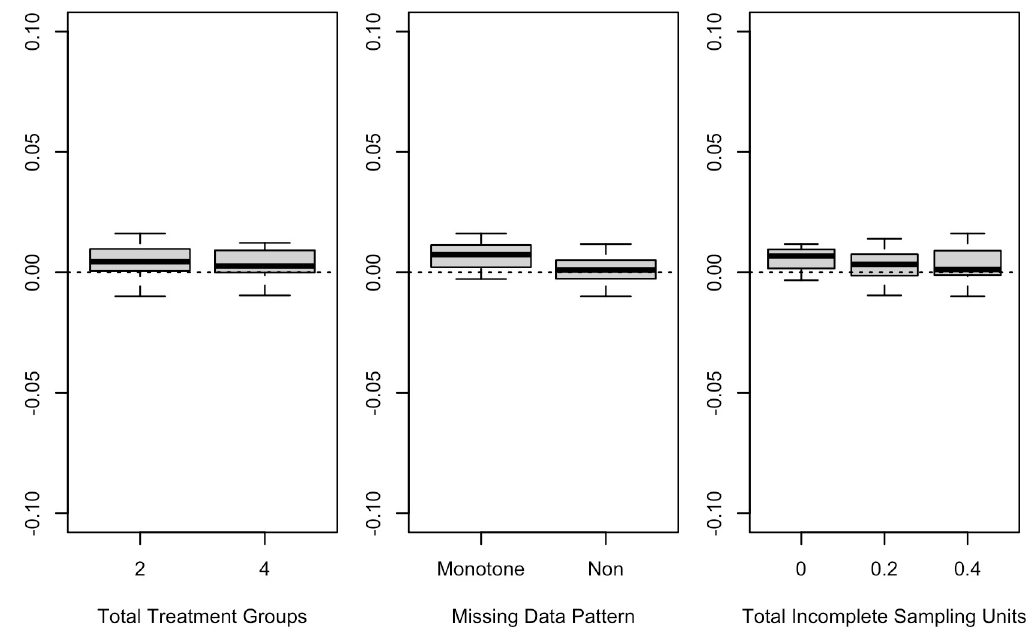
Fig 3. Power deviations in longitudinal designs. (center line, median; box limits, 1st and 3rd quartiles; whiskers, minimum and maximum). https://doi.org/10.1371/journal.pone.0254811.g003 Table 2 summarizes the design matrices and patterns of observations by cluster size and treat- ment assignment.